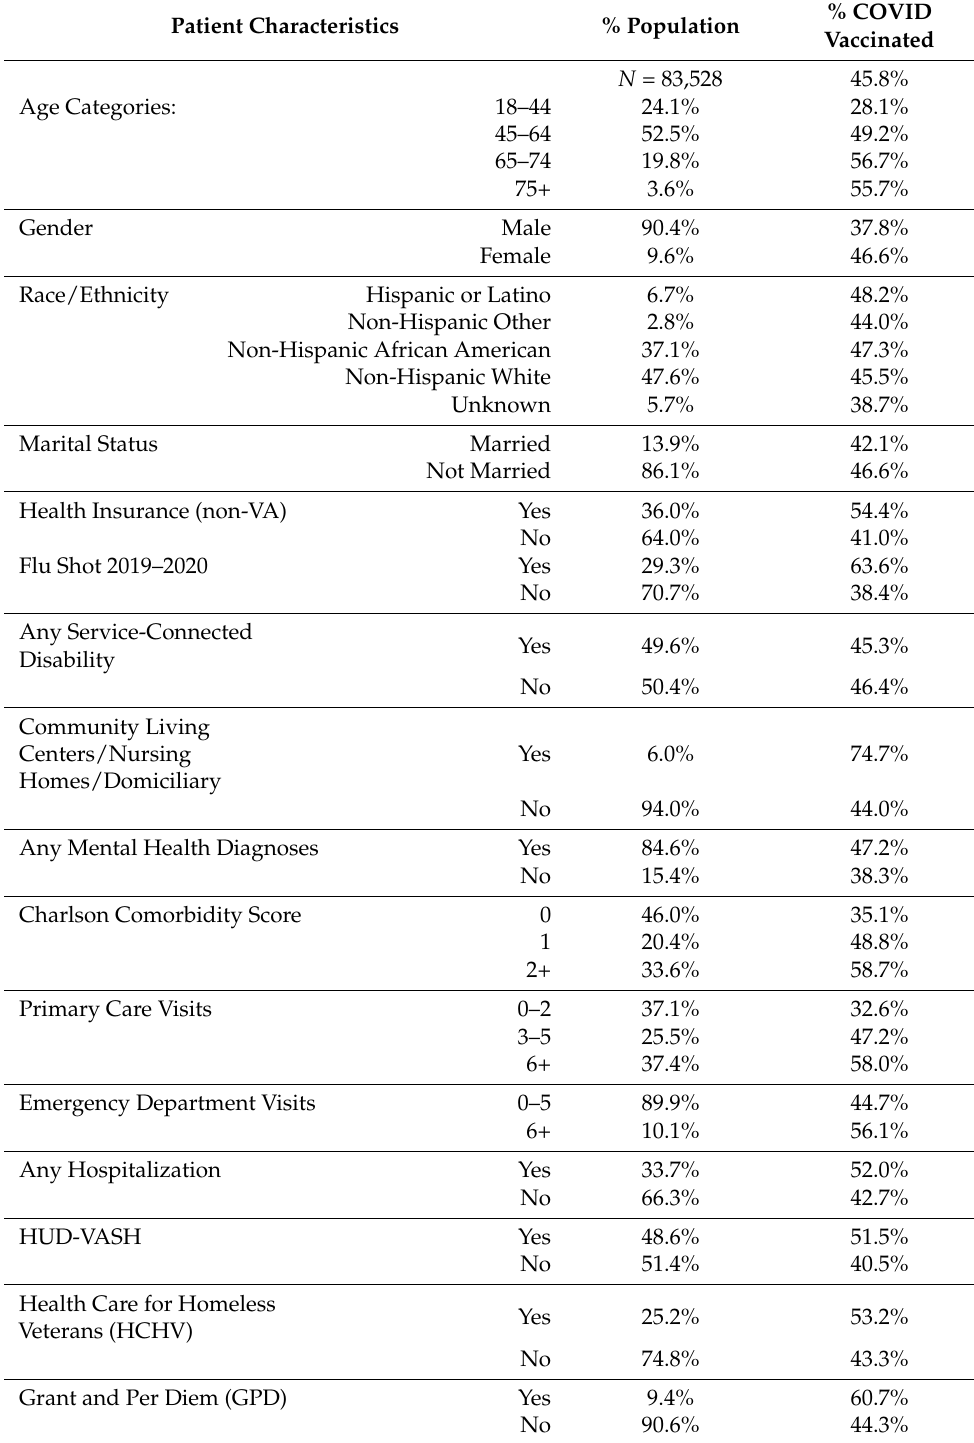
Table 1. Patient characteristics of Veterans experiencing homelessness (overall) and by COVID-19 vaccination